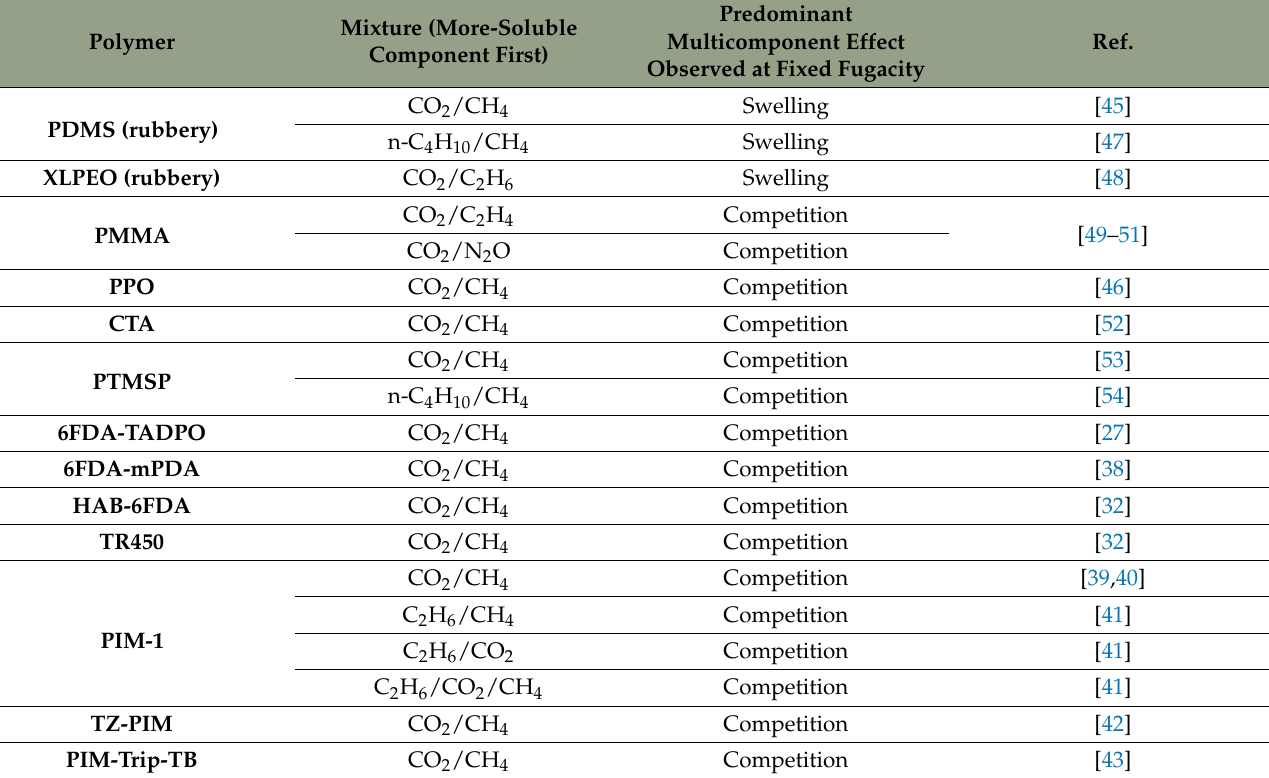
Table 2. Multicomponent effects documented during mixed-gas sorption in polymeric membranes. Polymer acronyms are defined in Appendix